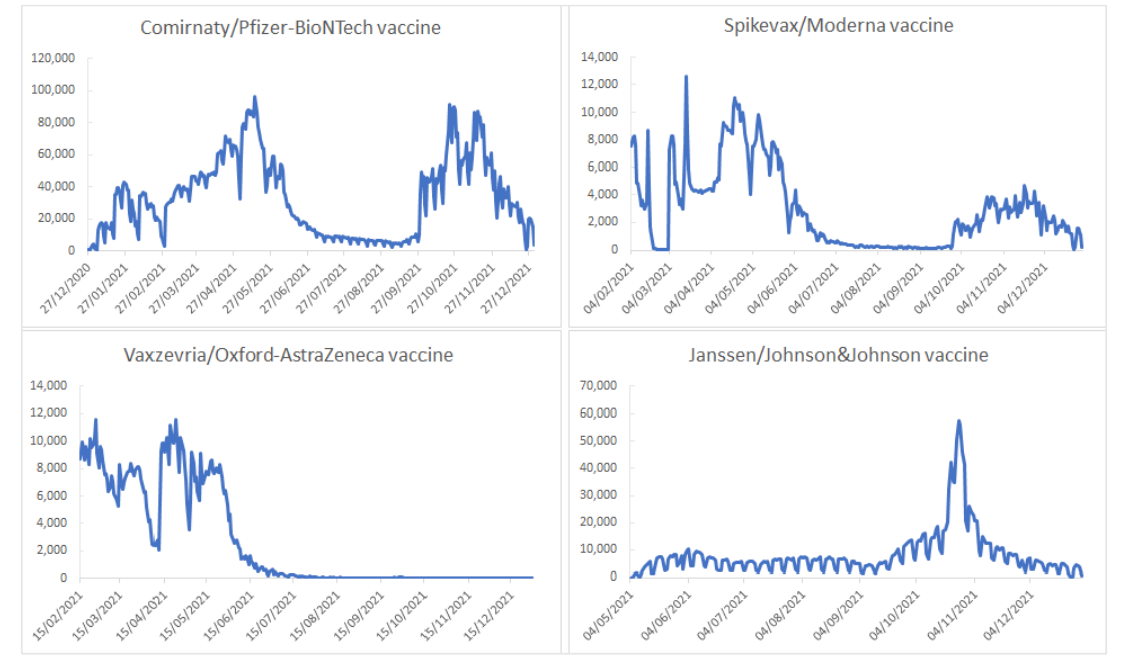
Figure 3. The pattern of vaccine use by brand over time, Romania, 27 December 2020–31 December 2021. Table 3. Distribution of lost doses by vaccine product, 27 December 2020–31 December 2021.